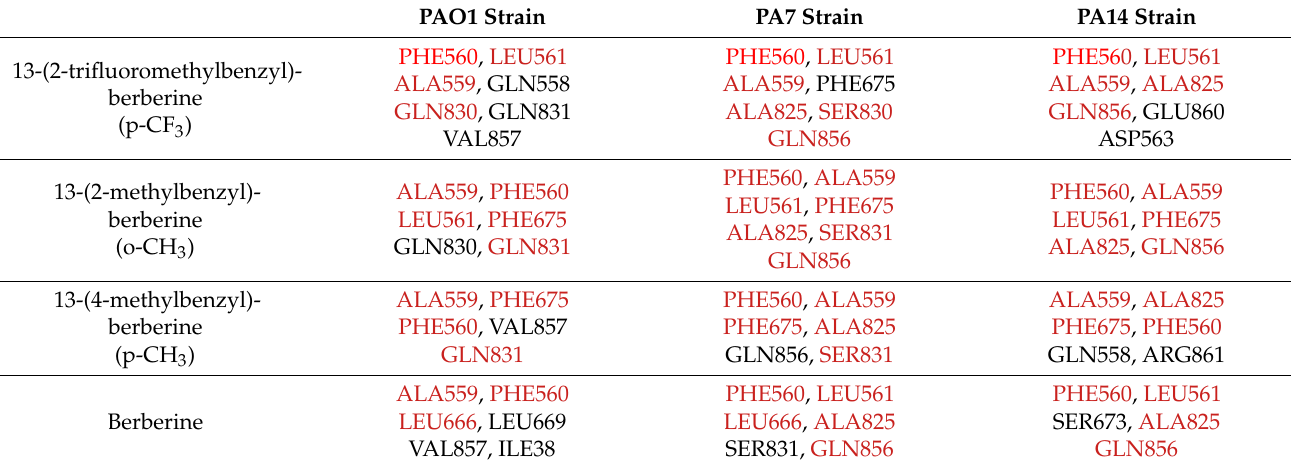
Table 3. Main residue interactions for berberine and its three derivatives in P. aeruginosa strains PAO1, PA7, and PA14. The common residues between the strains interacting with the ligands are reported in red. PAO1